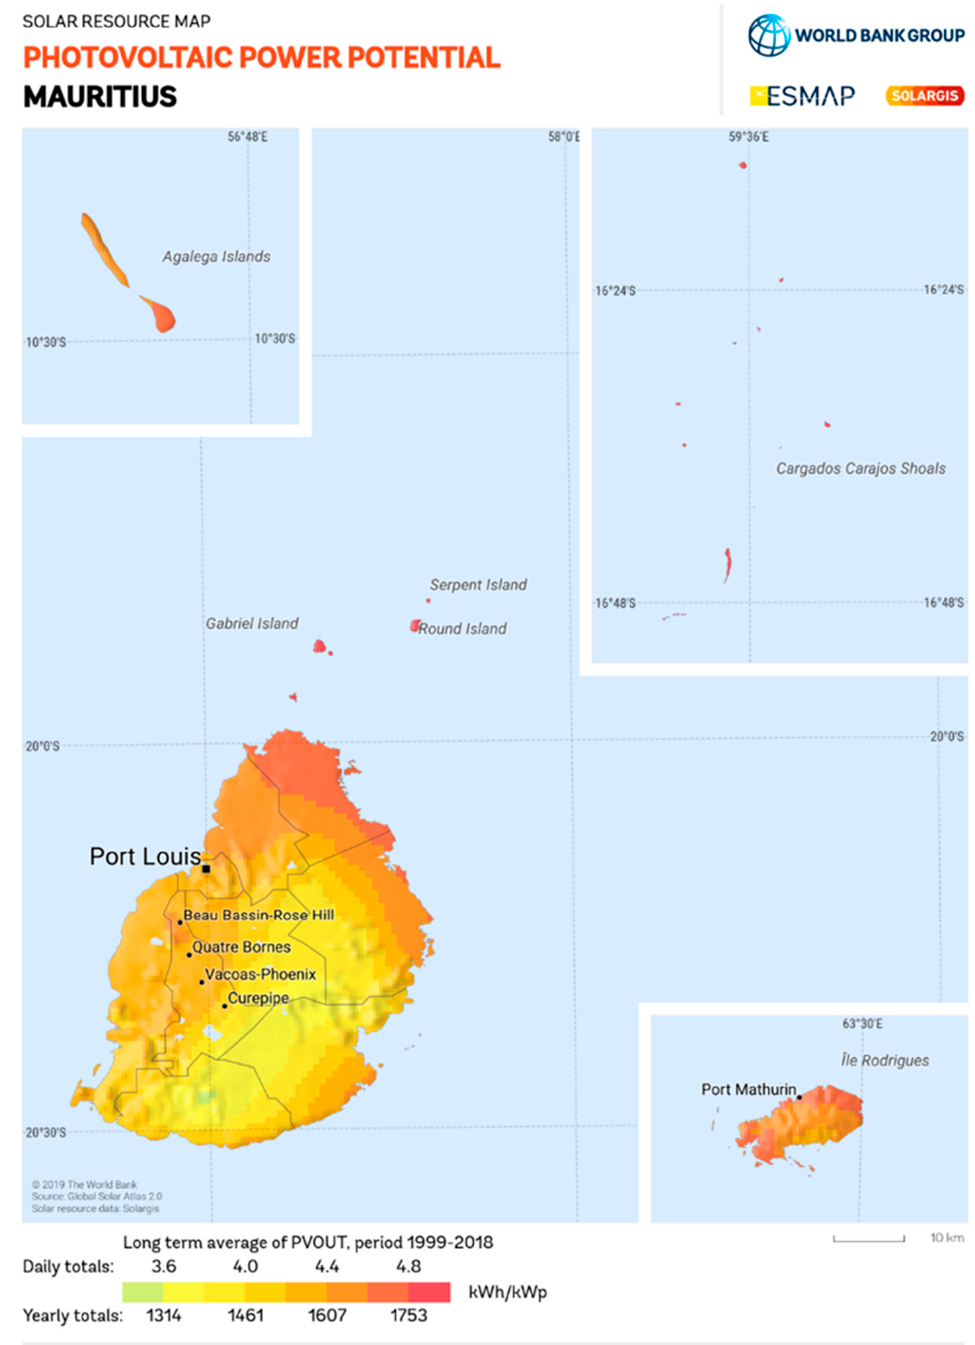
Figure 2. Long-term average PV output of the island of Mauritius, 1999–2018 [32].